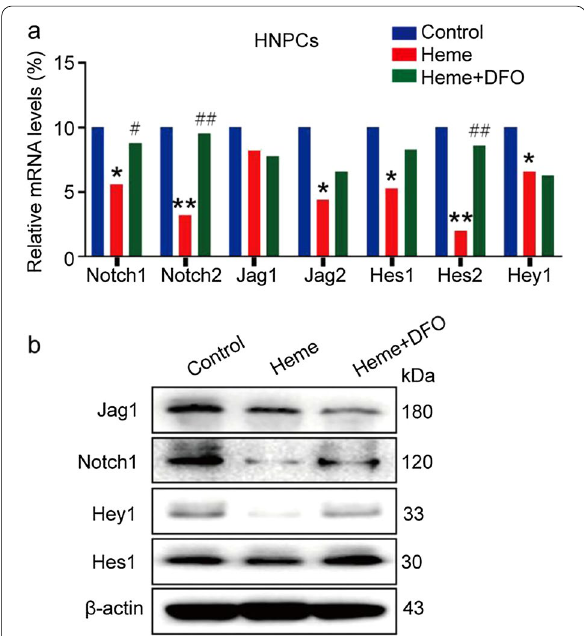
Fig. 7 Changes in the Notch signaling pathway in HNPCs after heme treatment. a Notch-related mRNAs in HNPCs were measured by qRT-PCR after 20 μg/mL heme treatment for 24 h with or without 30 μg/mL DFO pretreatment for 1 h. Data were analyzed with GraphPad Prism 5.02 software. *P < 0.05, **P < 0.01. b Notch-related proteins in HNPCs were measured by western blot analysis after 20 μg/mL heme treatment for 24 h with or without 30 μg/mL DFO pretreatment for 1